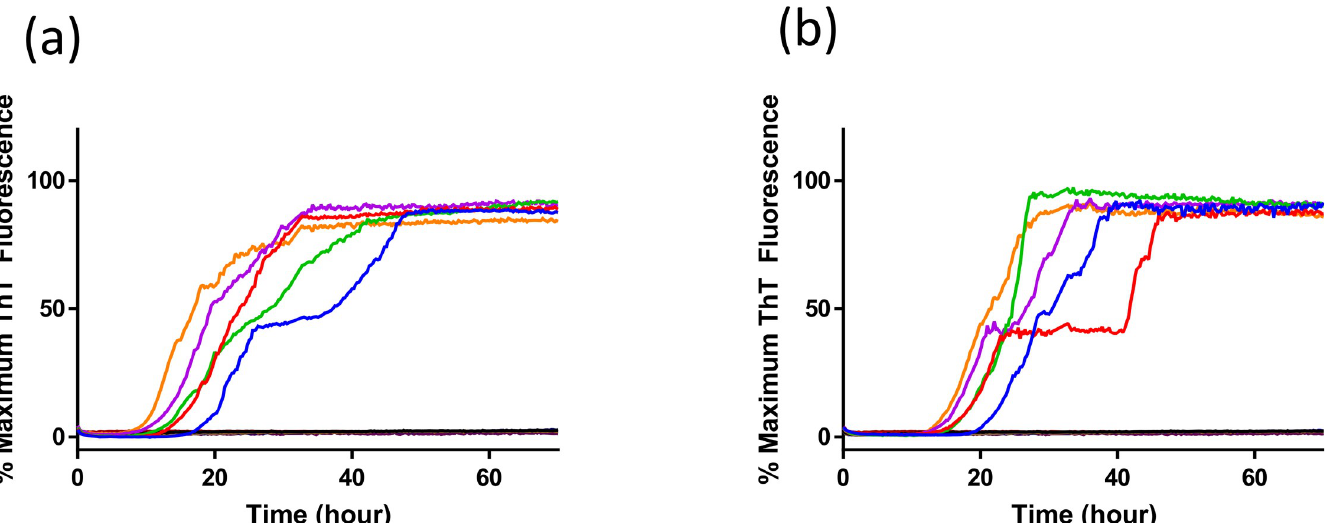
Fig 3. RT-QuIC sodium chloride titration for scrapie-infected and uninfected sheep brain samples. RT-QuIC reactions were seeded with 10 − 2 brain homogenate of animal number 2 (ARQ/ARQ;x124) using full-length elk prion protein 132L (a) and 132M (b) using a range of NaCl concentrations (100–500 mM, 100 mM: blue, 200 mM: red, 300 mM:green, 400 mM: purple, 500 mM: orange line). Data are presented as mean ThT fluorescence of 4 technical replicates. Uninfected sheep brain samples showed no increase in ThT regardless of NaCl concentration and the individual curves are not distinguishable as individual curves and appear as a thick dark line near 0% Maximum ThT Fluorescence.